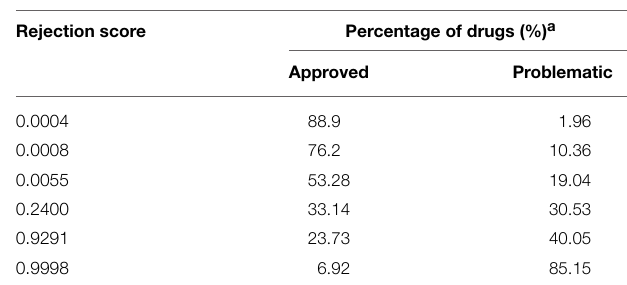
TABLE 1 | Percentage of drugs classified according to their Rejection